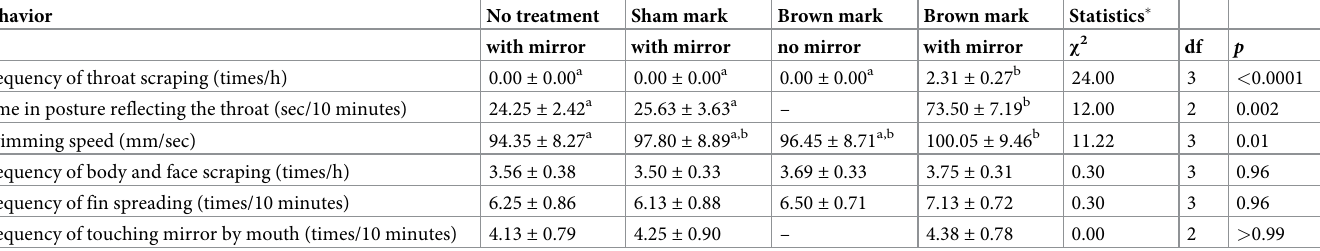
Table 1. Mean ± SEM cleaner fish behaviors in 4 different treatments ( n = 8 individuals) and results of statistical tests aimed at detecting differences between treat- ments. See S1 Data for raw data.